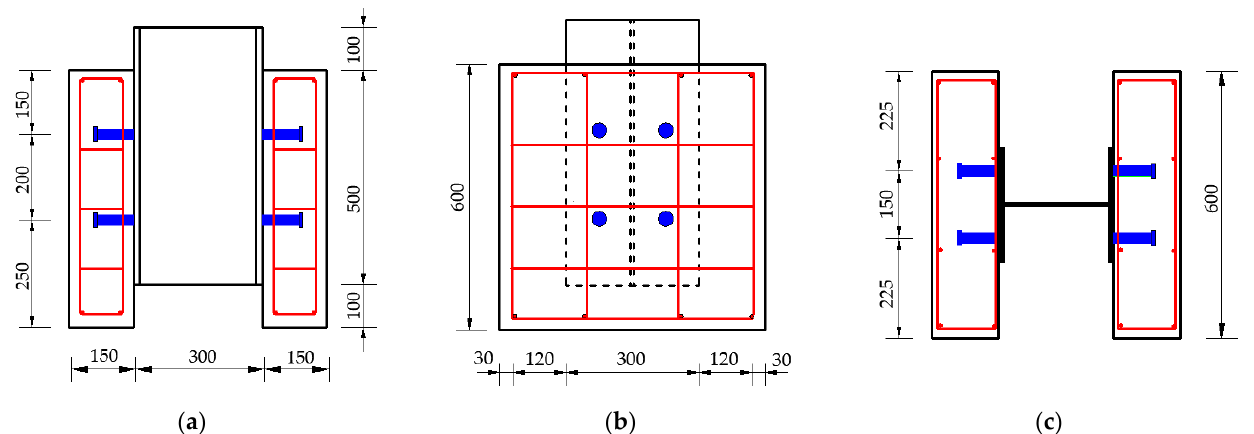
Figure 1. Details of specimens: ( a ) front view; ( b ) side view; ( c ) top view (unit: mm).